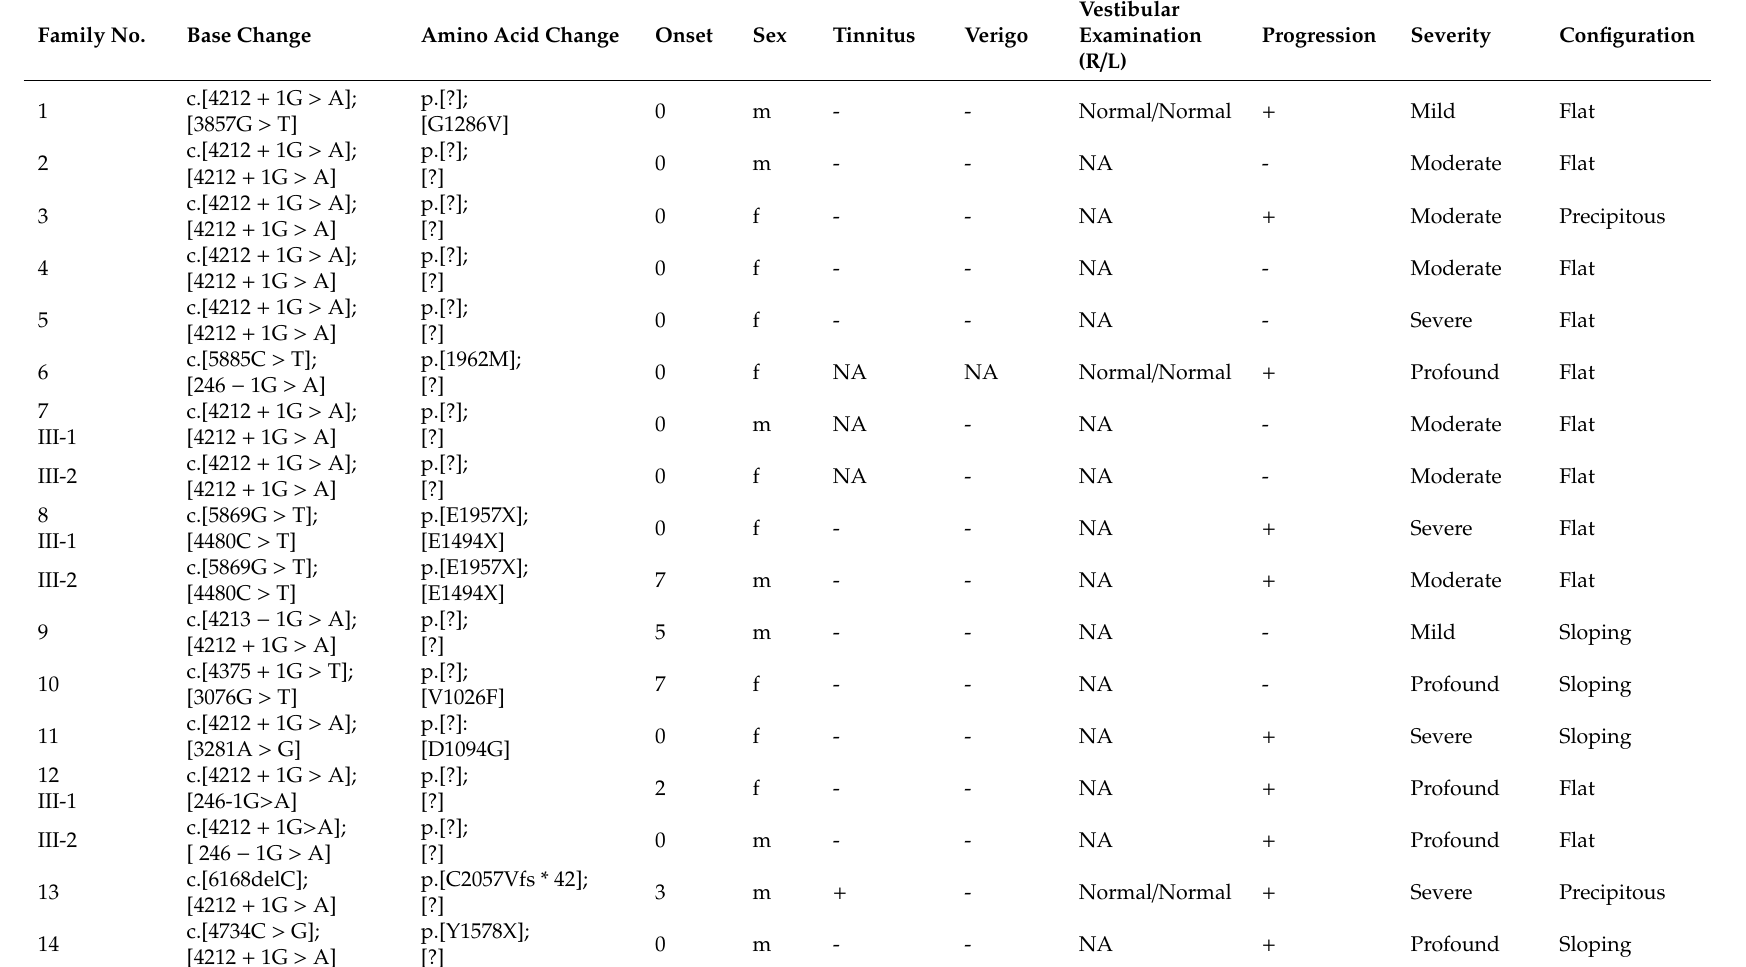
Table 2. Clinical findings of individuals with LOXHD1 variants identified in this study (NM_144612). Family